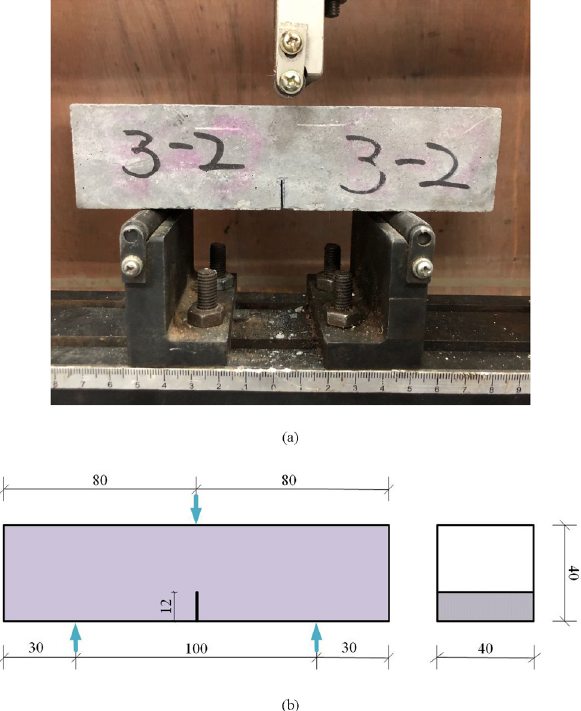
Figure 5: Matrix toughness testing: ( a ) device of the test and ( b ) dimension diagram of the specimen.